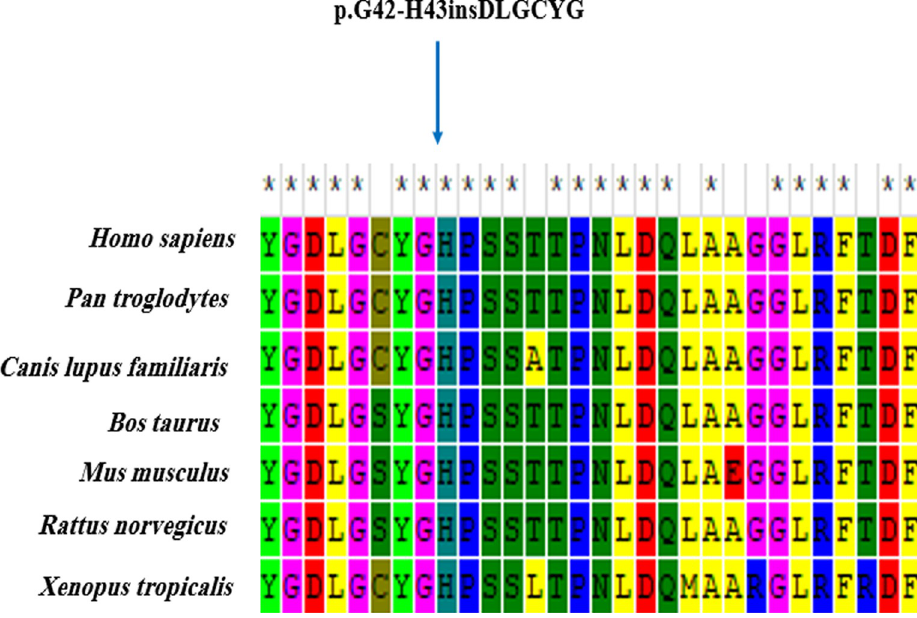
Fig 1. Phylogenetic alignment performed with MEGA6. The modified region is located in a highly conserved region among